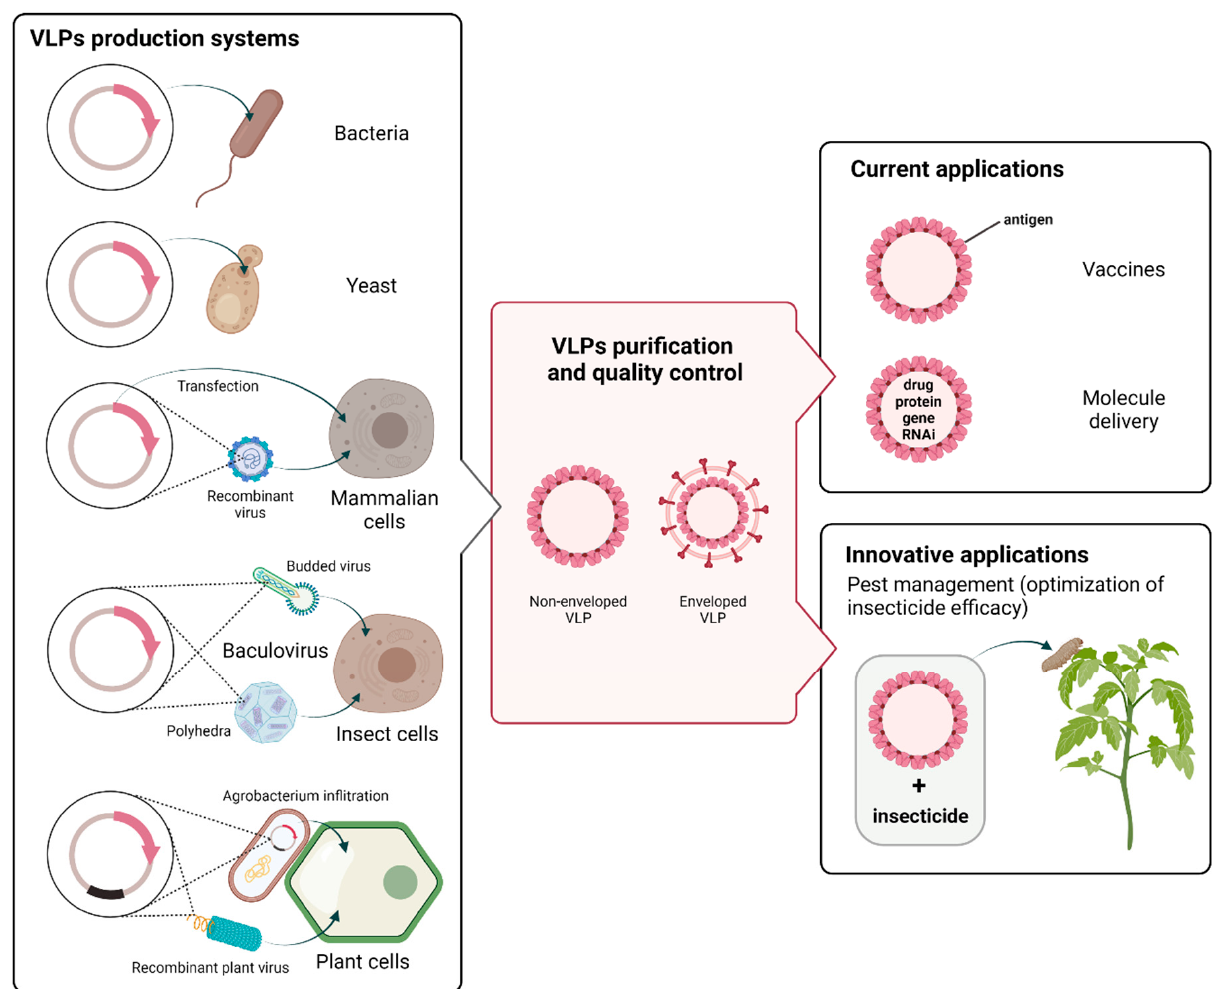
Figure 1. Virus-like-particles (VLPs) production systems and applications. VLPs can be produced by a variety of expression platforms, including prokaryotic and eukaryotic systems. The main eukaryotic systems include yeast, mammalian cell lines, the baculovirus/insect cell system, and plants. The production stage (left part of the figure) includes cloning of the viral structural genes of interest (in red) and introduction into the host cell by plasmid transfection or viral transduction. Depending on the method used, the transgene is integrated into the host genome or replicates in an episomal form. In plants, the rapid and transient expression of recombinant proteins is commonly based on Agrobacterium-mediated infiltration and/or plant viral vectors. After expression, the self-assembly of viral structural proteins into VLPs is highly dependent of the structure of viral proteins, the expression system, and the experimental conditions. VLPs that have similar structure as native virions can be enveloped or non-enveloped (central panel), spherical or filamentous, and composed of a single, double, or triple layer. Different downstream processing steps may be required to obtain purified VLPs without residual host contaminants. VLPs have a broad range of potential applications (right part of the figure), including vaccine production, vectors for gene therapy, and targeted drug delivery. Because VLPs are considered safer than viruses and capable of triggering the calcium concentration elevation, they could also be exploited as an alternative synergistic agent co-applied with a given insecticide for optimizing insecticide efficacy (created with Biorender.com, accessed on 3 November